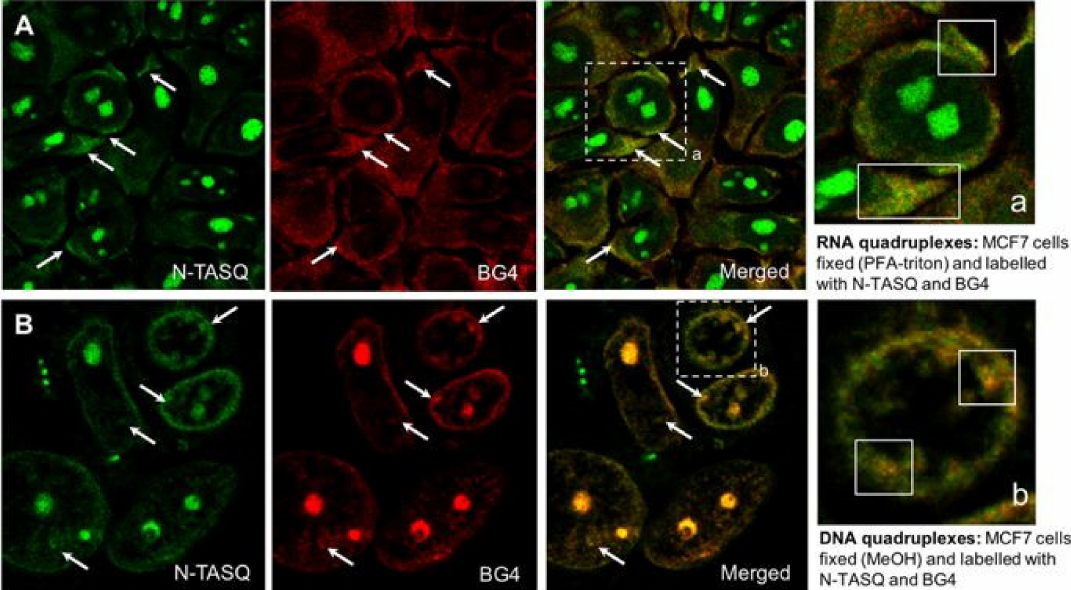
Figure 7. Confocal microscopy of MCF7 cells treated with N TASQ and BG4 (G-quadruplex specific antibody) and fixed with methanol indicates specificity of the probe for RNA and DNA G-quadruplex structures. (adapted with permission from